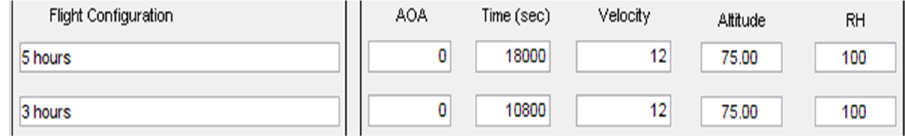
Figure 4. LewInt flight configuration.